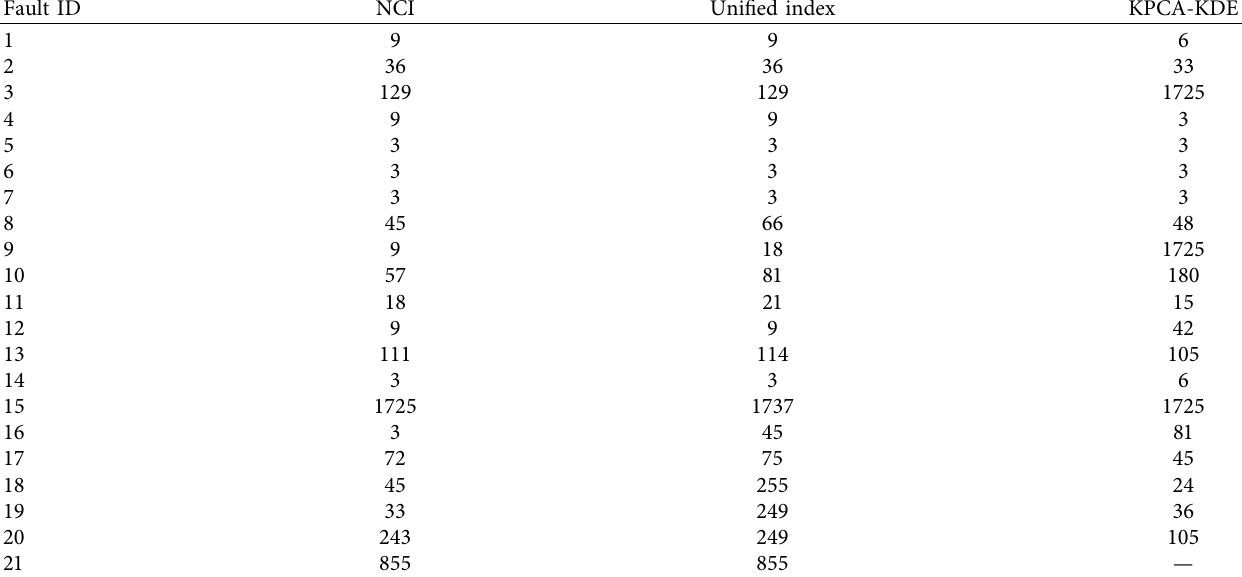
Table 4: Computation time in